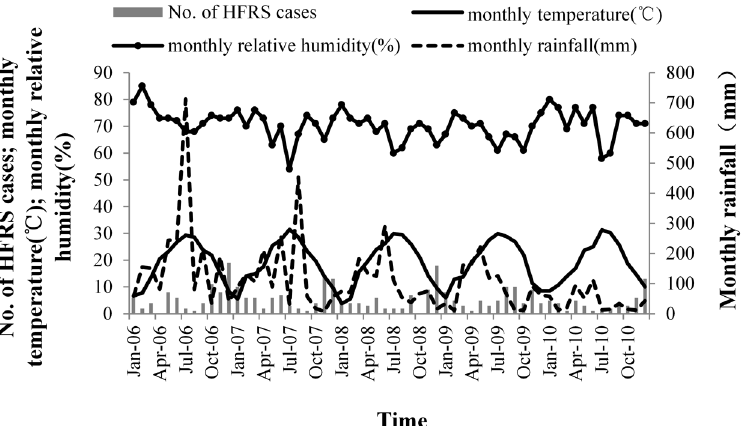
Figure 4. HFRS cases and meteorological factors.